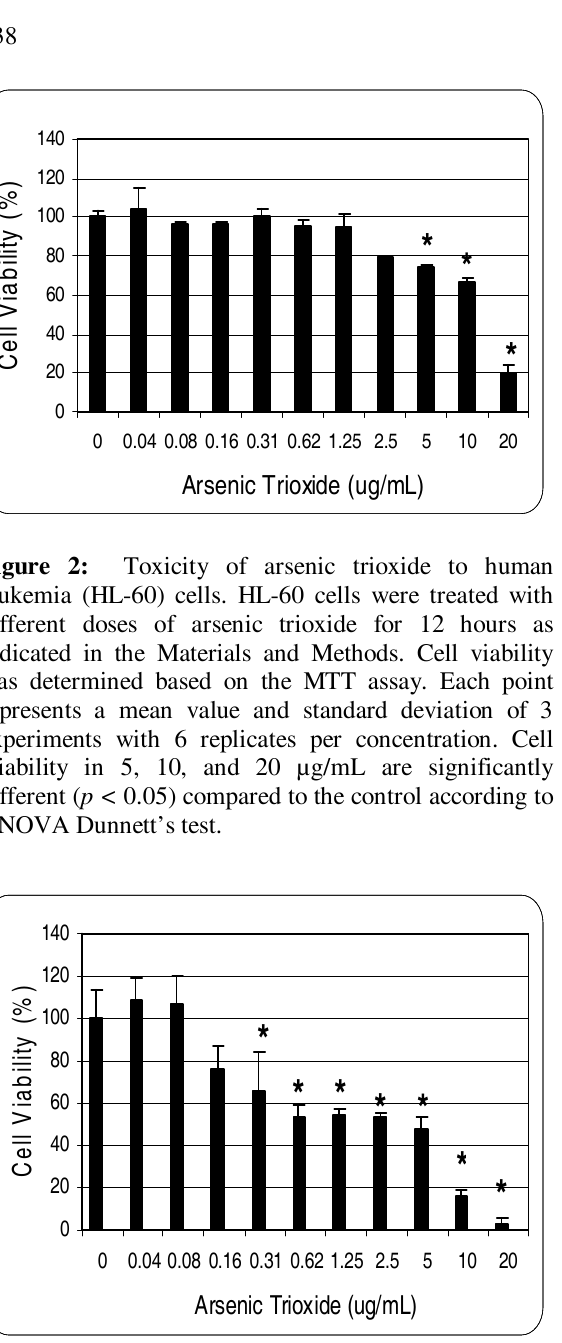
Figure 3: Toxicity of arsenic trioxide to human leukemia (HL-60) cells. HL-60 cells were cultured with different doses of arsenic trioxide for 24 hours as indicated in the Materials and Methods. Cell viability was determined based on the MTT assay. Each point represents a mean value and standard deviation of 3 experiments with 6 replicates per dose. All values are significantly different ( p < 0.05) compared to the control cells according to ANOVA Dunnett’s test, except 0.04- 0.08 µg/mL .